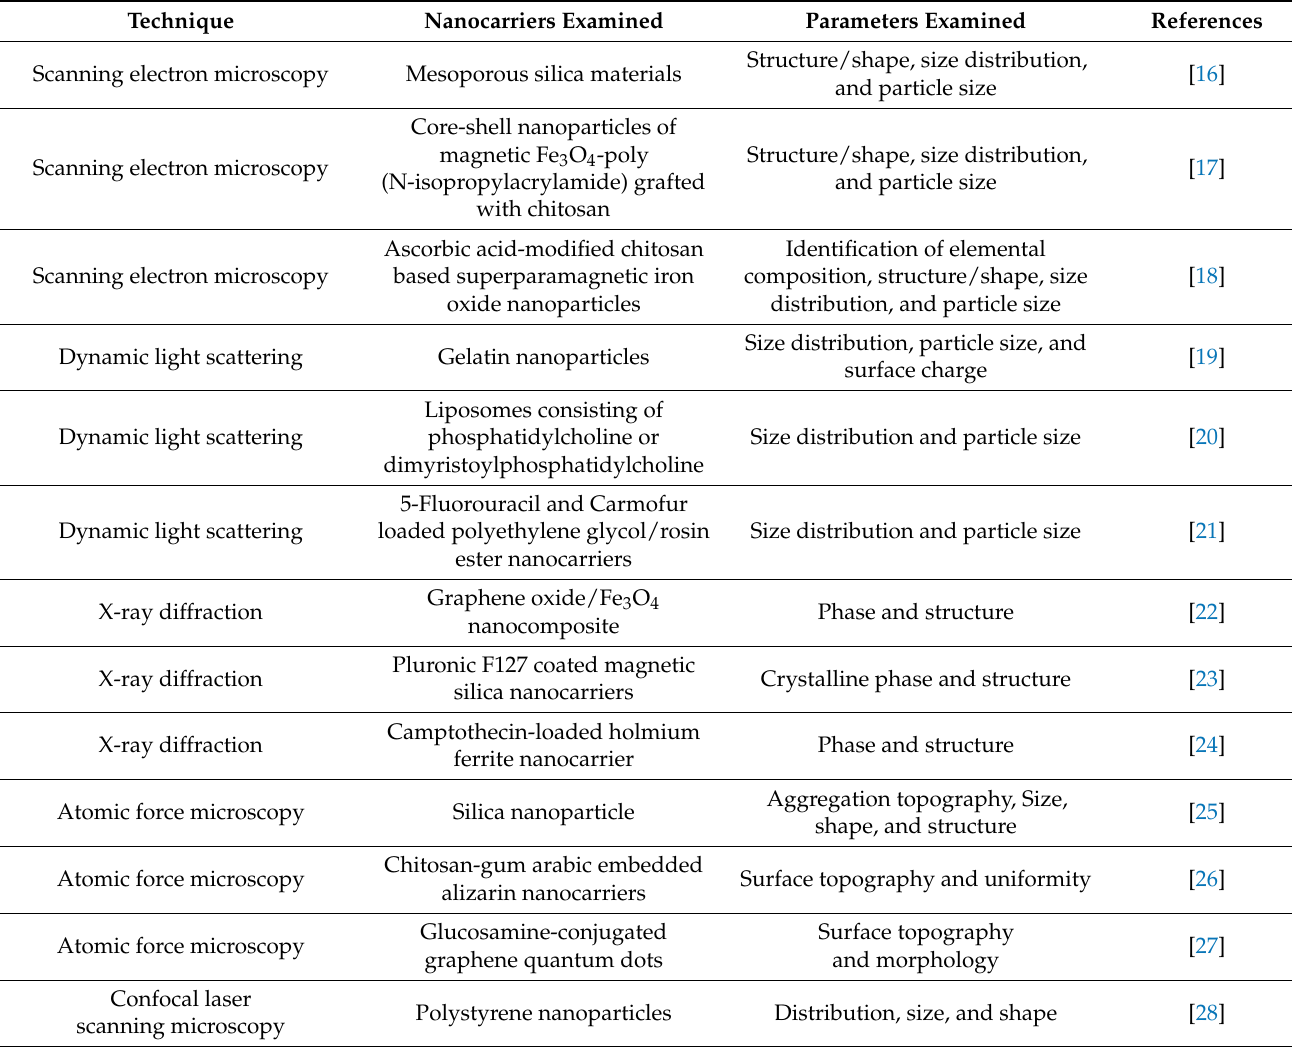
Table 1. Different non-destructive techniques used to characterize